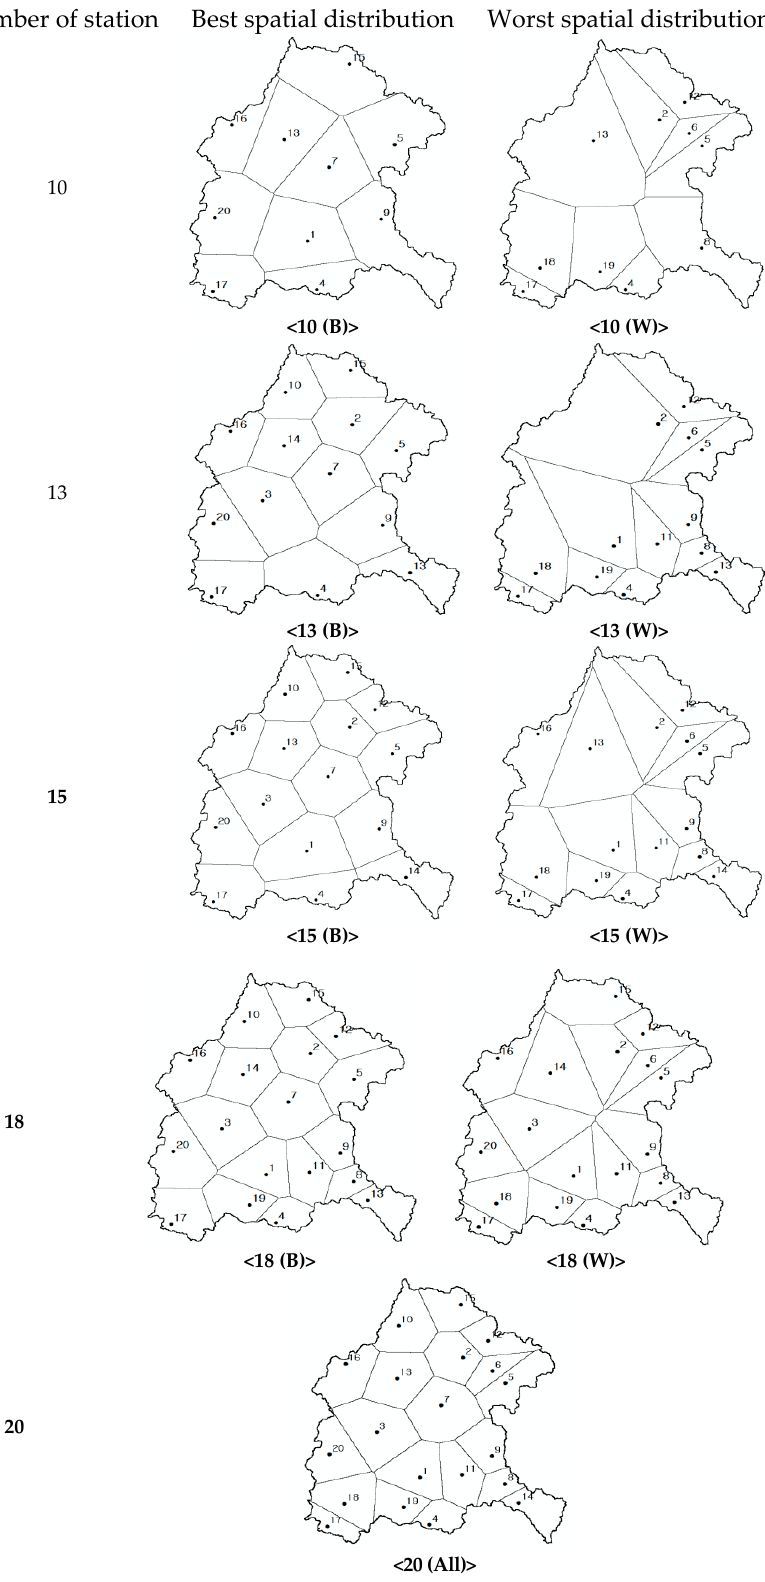
Figure 6. Rain Gauge Networks and Thiessen Polygon Depending on the Number of Rain Gauge Stations. Table 9. Spatial distribution Depending on the Number of Rain Gauge Stations.